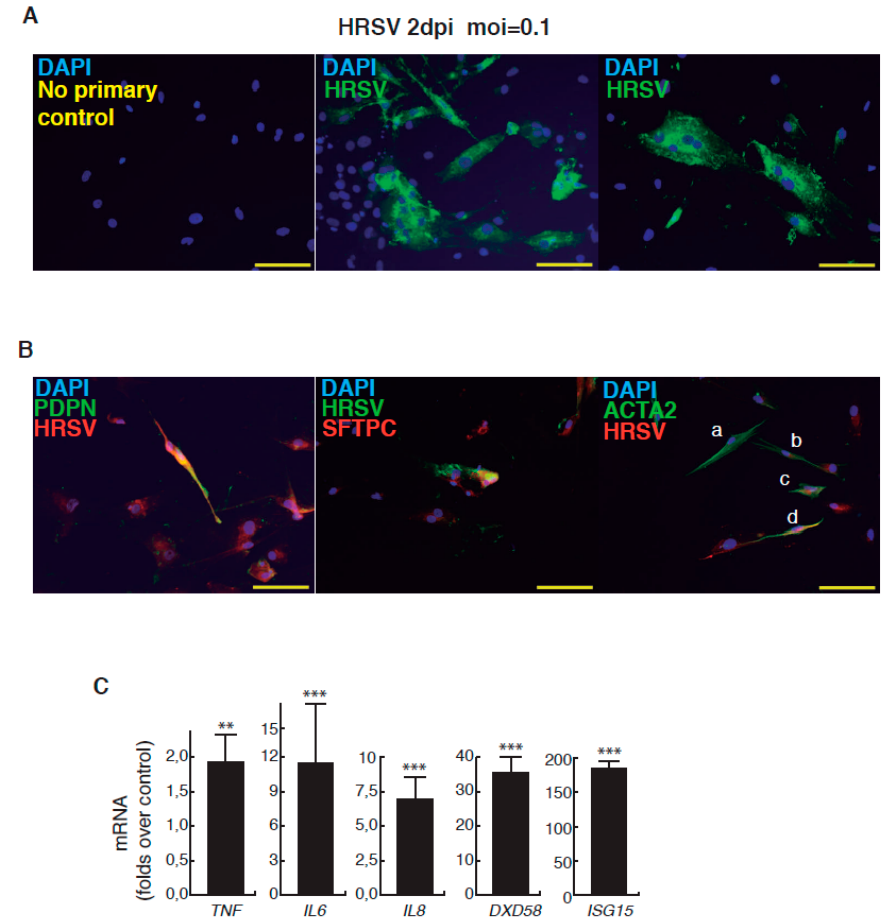
Figure 3. Infection of minilungs by HRSV (moi 0.1). ( A ) Detection by indirect immunofluorescence of viral antigens by using a mix of mAbs directed against HRSV (Supplementary Information); 2 dpi: 2 days post-infection; scale bars: 50 µ m; ( B ) Left panel: double detection of podoplanin (PDPN), a marker of ATI cells, and of viral antigens (F glycoprotein); HRSV antibody used is a rabbit polyclonal antibody raised against the F glycoprotein (supplementary information). Center panel: double detection of mature surfactant C protein (SFTPC), a marker of ATII cells, and of viral antigens. HRSV antibodies used: mix of mouse mAbs directed against HRSV. Right panel: double detection of ACTA2 ( α -SMA (alpha smooth muscle actin), marker of myofibroblasts) and of viral antigens. Cells “a” and “b” show no significant reactivity to HRSV antibodies; cells “c” and “d” show the merged color indicative of a moderate infection. HRSV antibodies used: mix of mouse mAbs directed against HRSV; scale bars: 50 µ m; ( C ) Relative levels of expression of representative genes of the proinflammatory and innate immune responses induced by HRSV. Infections were performed at moi 0.1 and total RNA was extracted at 2 dpi. Values are folds over control (uninfected minilungs). (**, p <0.01; and ***, p < 0.001)